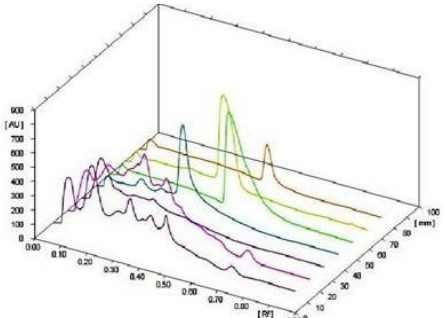
Fig. 12. 3D display of HPTLC chromatogram of M. cymbalaria fruit extracts and standards